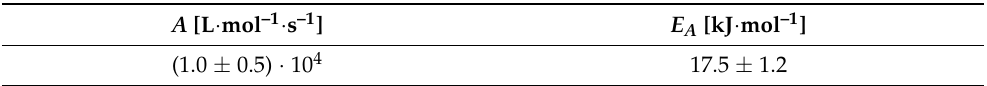
Table 5. Experimental Arrhenius parameters for chain-length-averaged k p of DnPI, obtained via